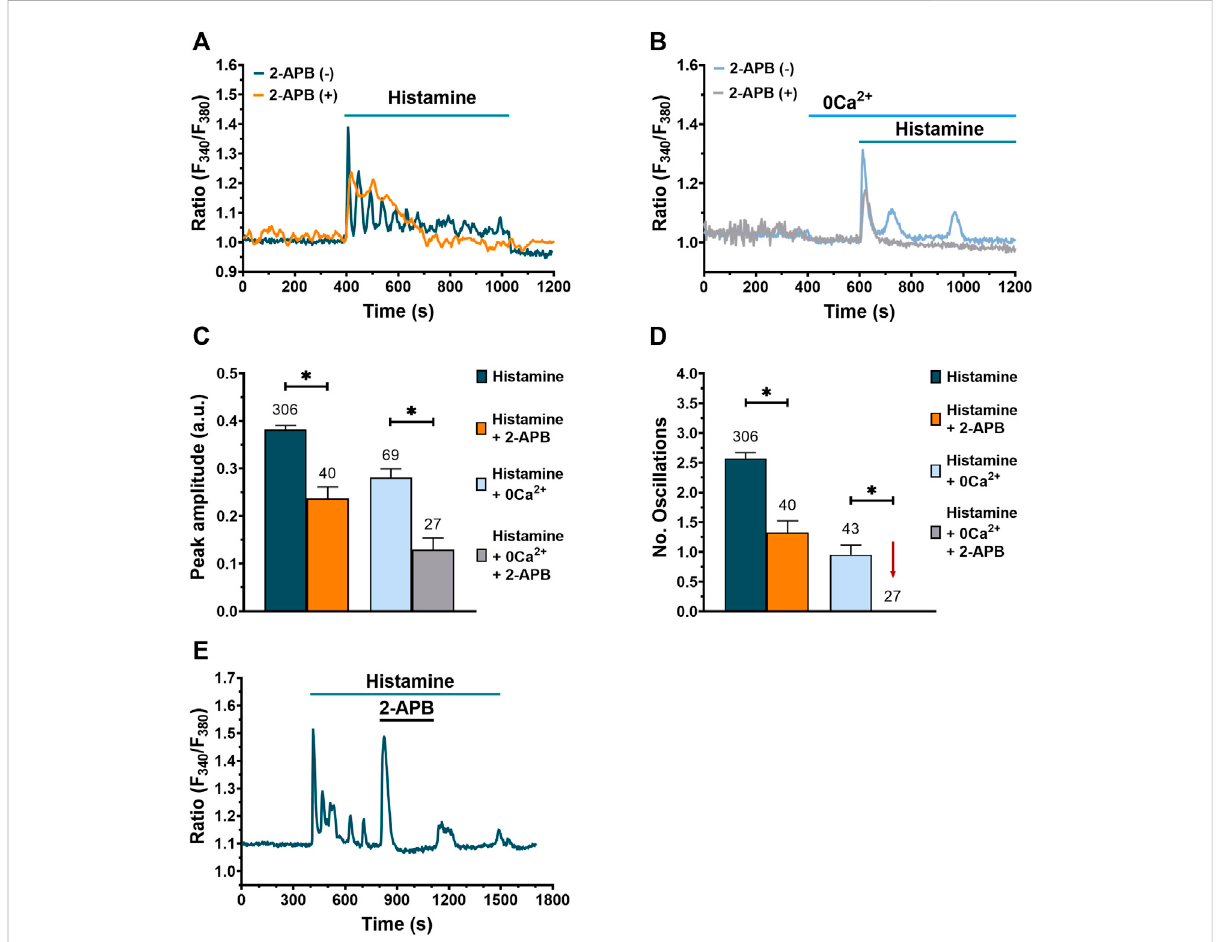
FIGURE 6 Involvement of InsP 3 R in histamine-evoked Ca 2+ signals in WI-38 human lung fi broblasts. (A) Typical recording of the Ca 2+ response to histamine(300 µM)in fi broblastspre-incubatedwith2-APB(50 μ M)for20 min[orangetrace,2-APB(+)]anditscontrol[darkgreentrace,2-APB(-)]. (B) Typical recording of histamine-evoked Ca 2+ signal in absence of extracellular Ca 2+ (0Ca 2+ ) after pre-incubation of fi broblasts for 20 min with 2- APB (50 μ M) [gray trace, 2-APB (+)] and its control [blue trace, 2-APB (-)]. In (A , B ) basal Ca 2+ levels were aligned for comparative purposes. (C) Mean±SEofthepeakamplitudeoftheCa 2+ responsetohistamine(300 µM)innormalextracellularCa 2+ andinabsence(darkgreenbar)orpresence of 50 μ M 2-APB (orange bar). Mean ± SE of the peak amplitude of the Ca 2+ response to histamine (300 µM) in absence of extracellular Ca 2+ (0Ca 2+ ) and in absence (blue bar) or presence of 50 μ M 2-APB (gray bar). Statistic comparison between groups was performed using Mann-Whitney and t-Student test respectively (* = p ≤ 0.05). (D) Mean ± SE of the number of oscillations evoked by histamine (300 µM) in normal extracellular Ca 2+